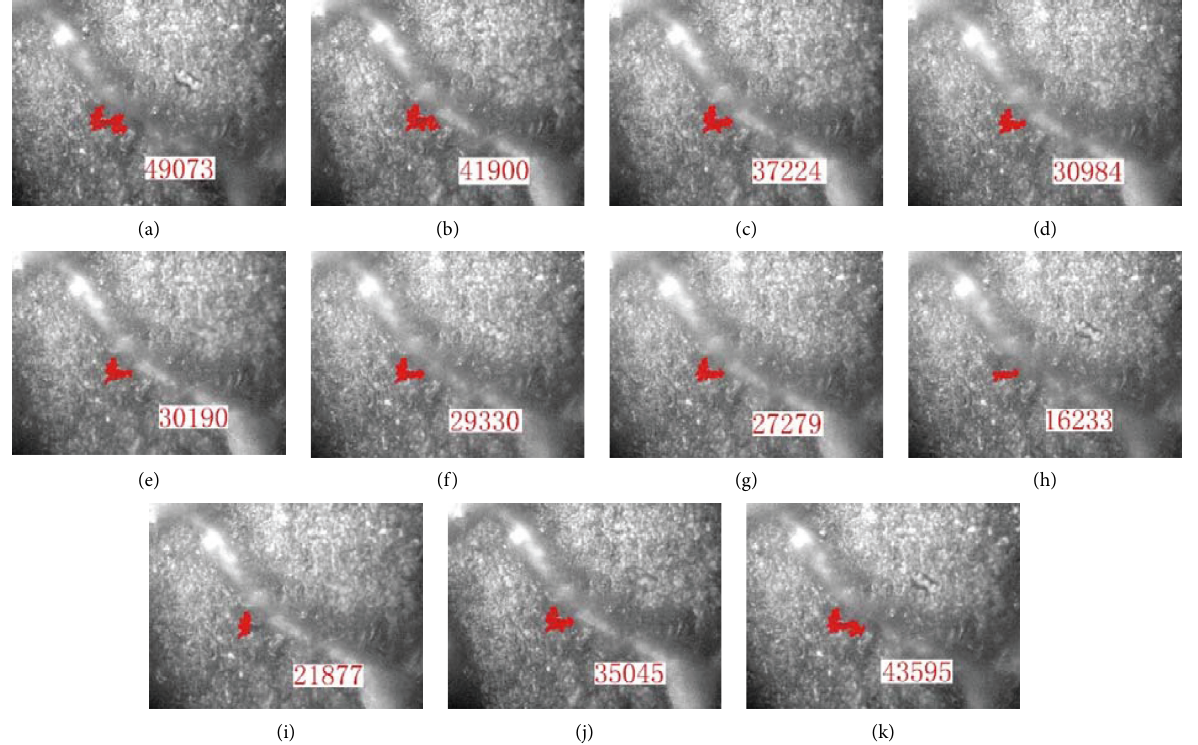
Figure 7: Microimage of identification pore changes of fine sandstone sample with the increasing temperature. (a) 22 ° C; (b) 60 ° C; (c) 90 ° C; (d) 120 ° C; (e) 150 ° C; (f) 180 ° C; (g) 210 ° C; (h) 240 ° C; (i) 270 ° C; (j) 300 ° C; (k) 350 ° C.